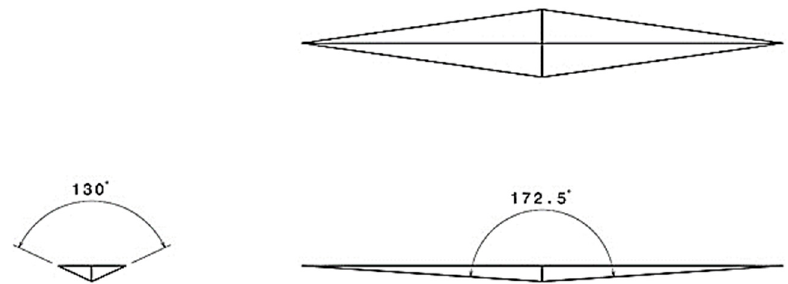
Figure 1. Schematic representation of the Knoop indenter geometry.